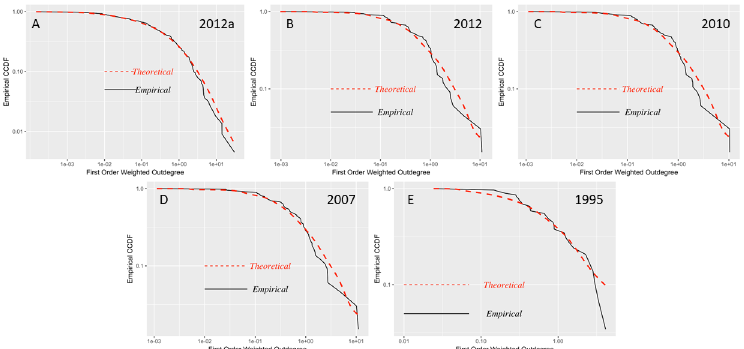
Fig 5. CCDF first-order weighted outdegree input-output matrices1995–2012. (A) Detailedmatrix 2012, 245 economicsectors. (B) Summary matrix 2012, 71 economicsectors. (C) Matrix 2010, 71 economic sectors. (D) Matrix 2007, 71 economicsectors. (E) Matrix 1995, 34 economicsectors. Log-log plots of the empiricalcounter-cumulative density functions(CCDF) of the weightedfirst-order outdegree.